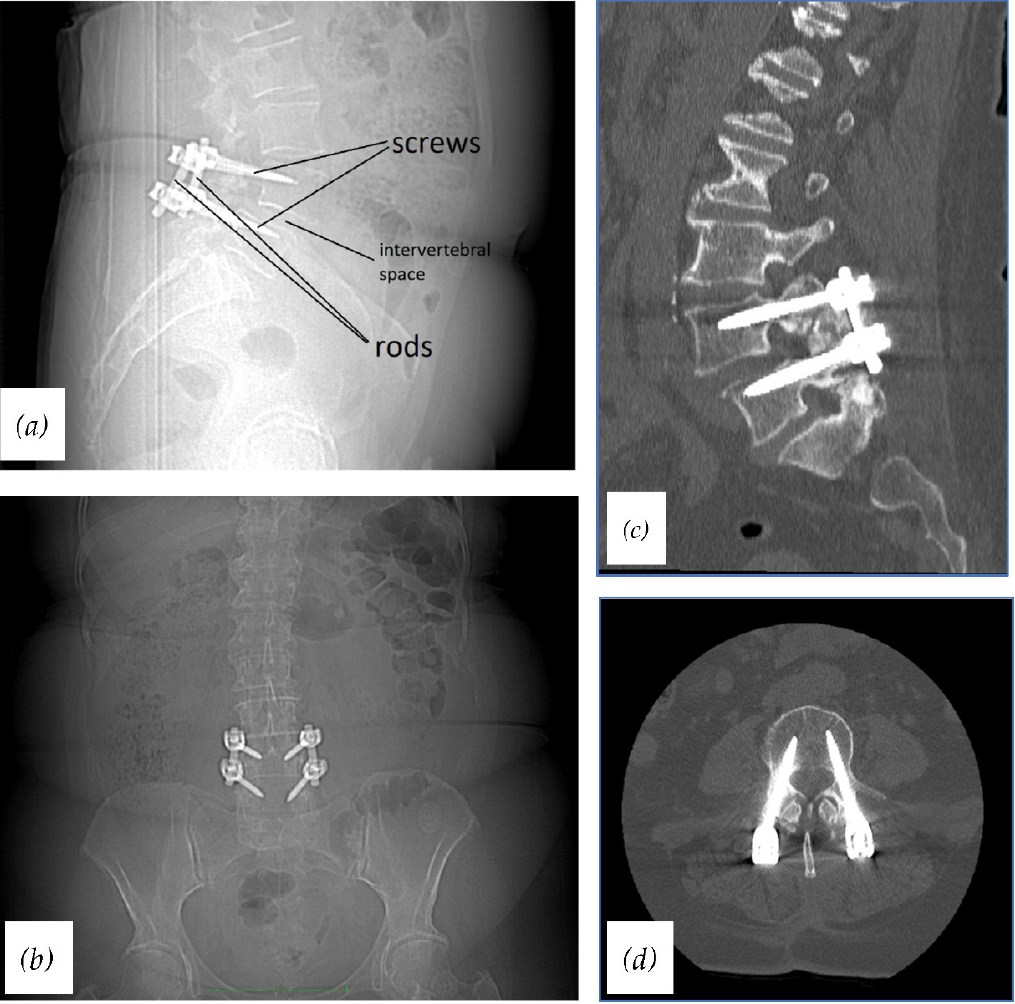
Figure 1. Radiographs and CTs of stabilized lumbar spine using the standard spinal fixation device: ( a ) Radiograph, lateral view (with descriptions); ( b ) radiograph, AP view; ( c ) CT, sagittal plane; ( d ) CT, axial